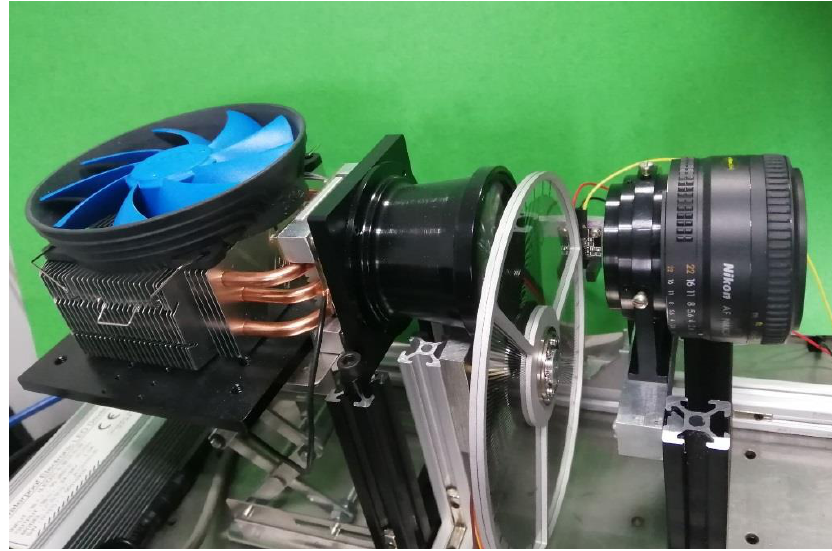
Figure 9. Experimental setup.